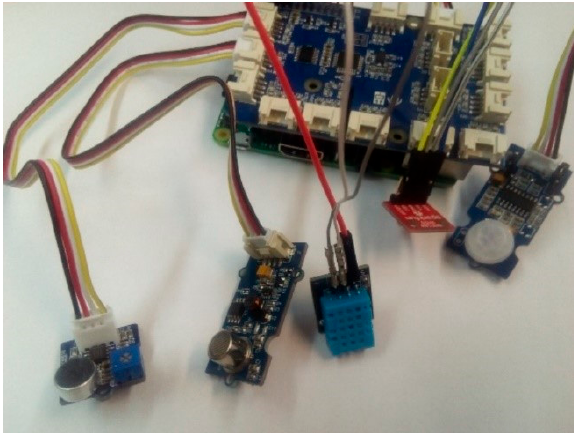
Figure 6. Hardware prototype implemented.